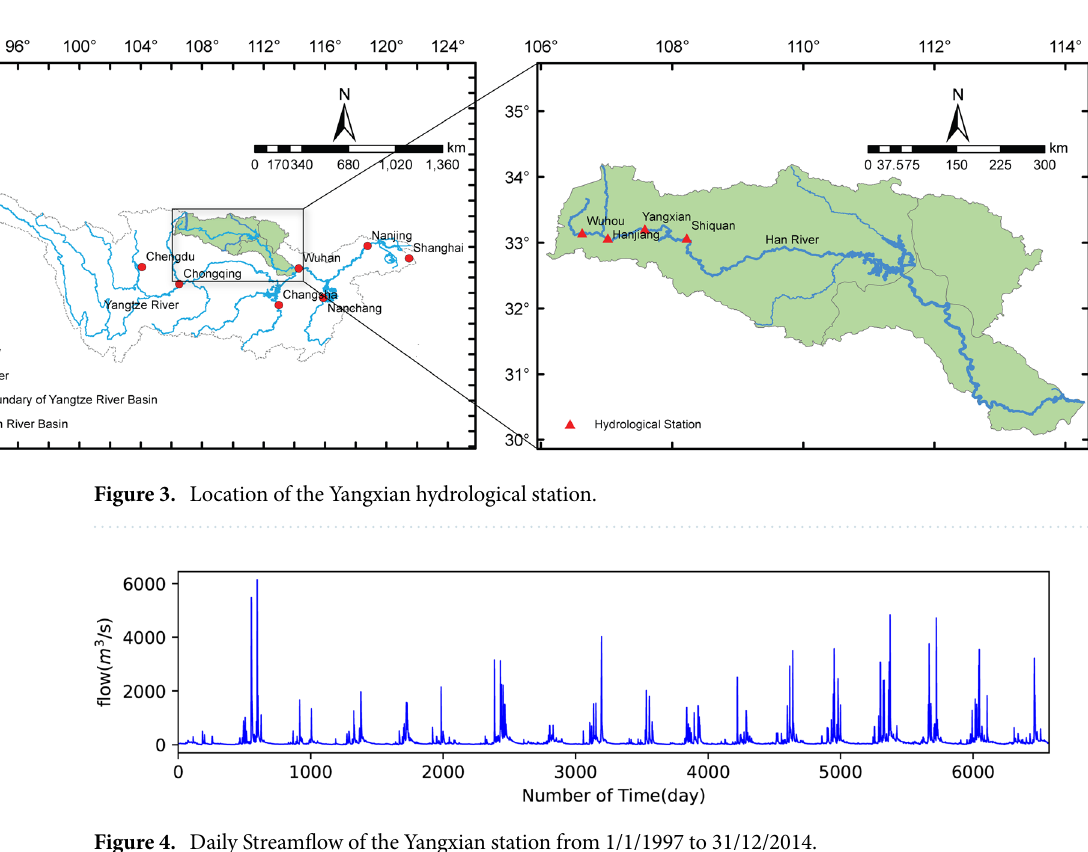
Figure 4. Daily Streamflow of the Yangxian station from 1/1/1997 to